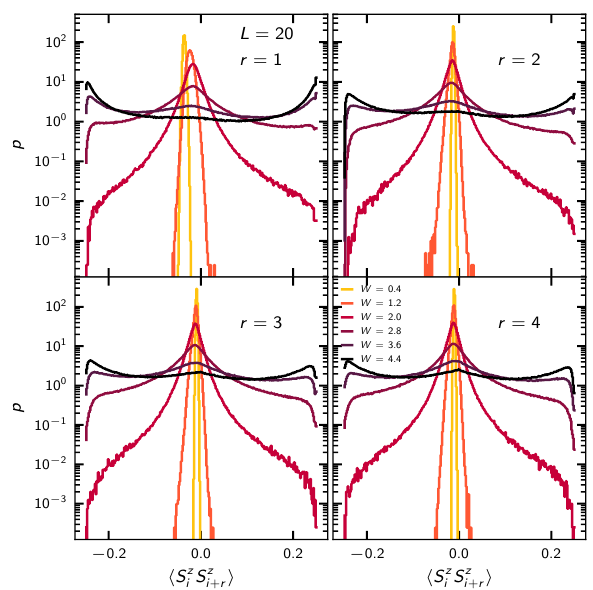
| n 〉 for dis- S z i i + r